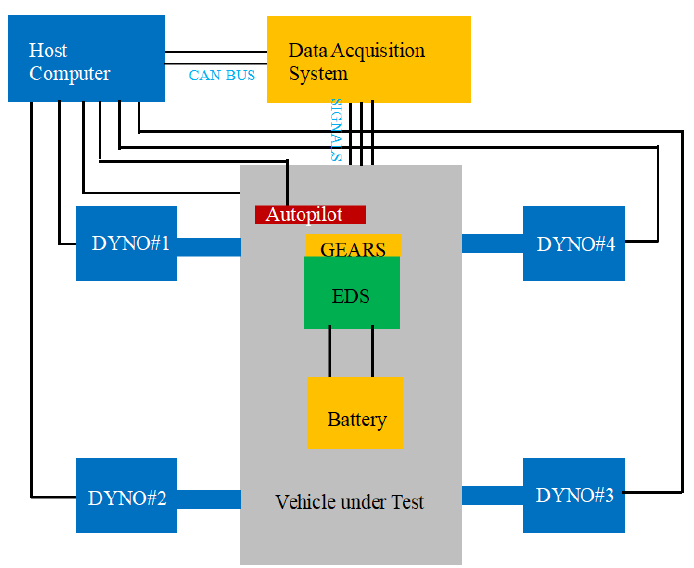
Figure 5. Schematic diagram of the test bench on the vehicle level.